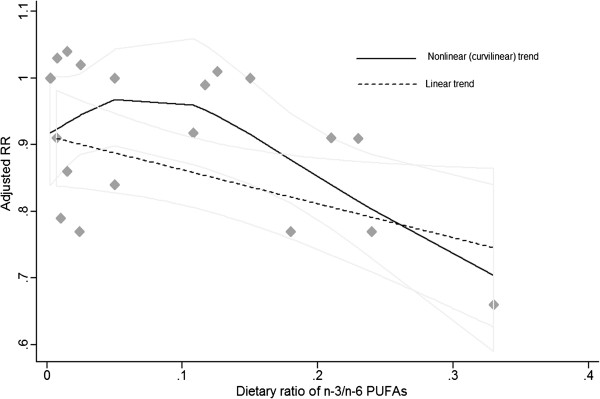
Summarized dose–response association between dietary ratio of n-3/n-6 PUFAs and risk of breast cancer. Adjusted RRs from each exposure quantile of dietary ratio of n-3/n-6 PUFAs in included individual studies were represented by the gray diamonds, and corresponding intervals (CIs) were represented by the lightgray trendline. The dash line indicated that dose–response linear trend (Ptrend = 0.012) between dietary ratio of n-3/n-6 PUFAs and risk of breast cancer by use of variance-weighted least squares regression of fixed effect model; the black curve indicated nonlinear (curvilinear) trend (Ptrend = 0.018) by use of restricted cubic splines functional model with three knots at percentiles 25%, 50%, and 75% of the distribution.